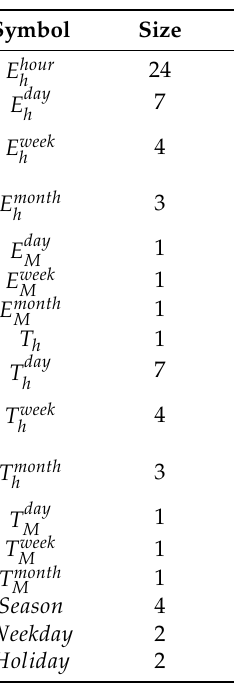
Table 2. Input data for the load forecast of the h th